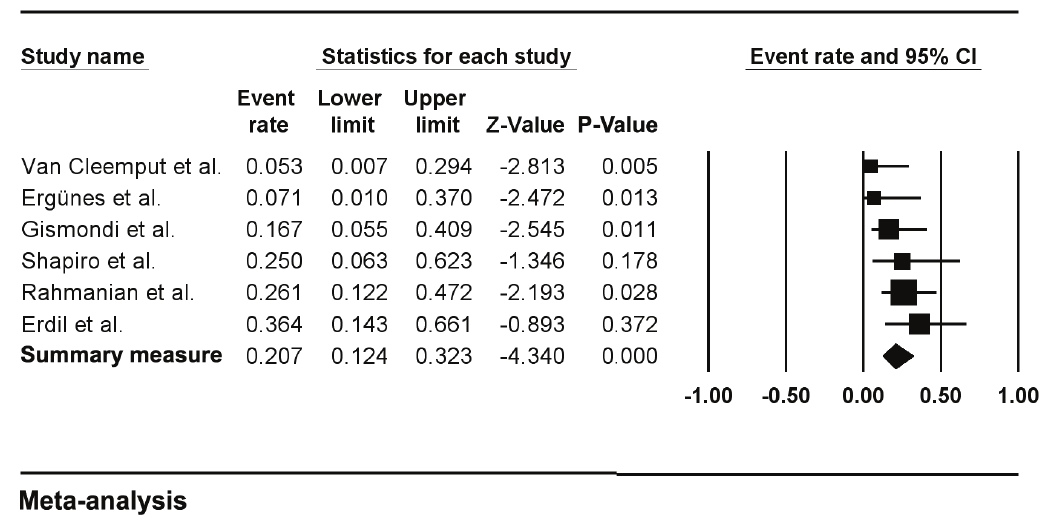
Figure 2. Forest plot of prevalence rate of CAD in adult myxoma patients in 6 studies. Horizontal lines represent 95% confidence intervals (CIs). Each box represents the prevalence rate point estimate, and its area is proportional to the weight of the study determined by inverse variance weighting. The diamond represents the overall summary estimate, with the 95% CI given by its width.